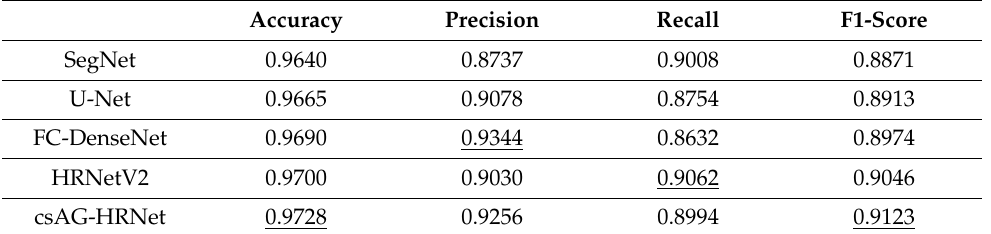
Figure 9. Detailed results for site 1 (residential area) according to each deep learning model. Red indicates false positives, and cyan indicates false negatives. ( a ) Original image. ( b ) Ground-truth labels. ( c ) Results of SegNet. ( d ) Results of U-Net. ( e ) Results of FC-DenseNet. ( f ) Results of HRNet-v2. ( g ) Results of csAG-HRNet. Table 2. Quantitative building extraction results for site 1 (residential area) according to each deep learning